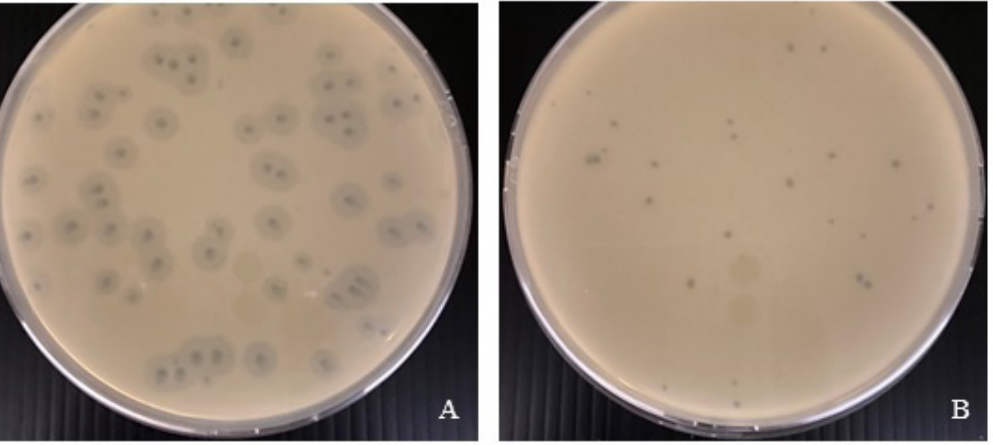
Figure 1: Plaque formation by double layer nutrient agar plates of B . cereus bacteriophages isolated from Thua Nao: BaceFT01 (A) and BaceCM02